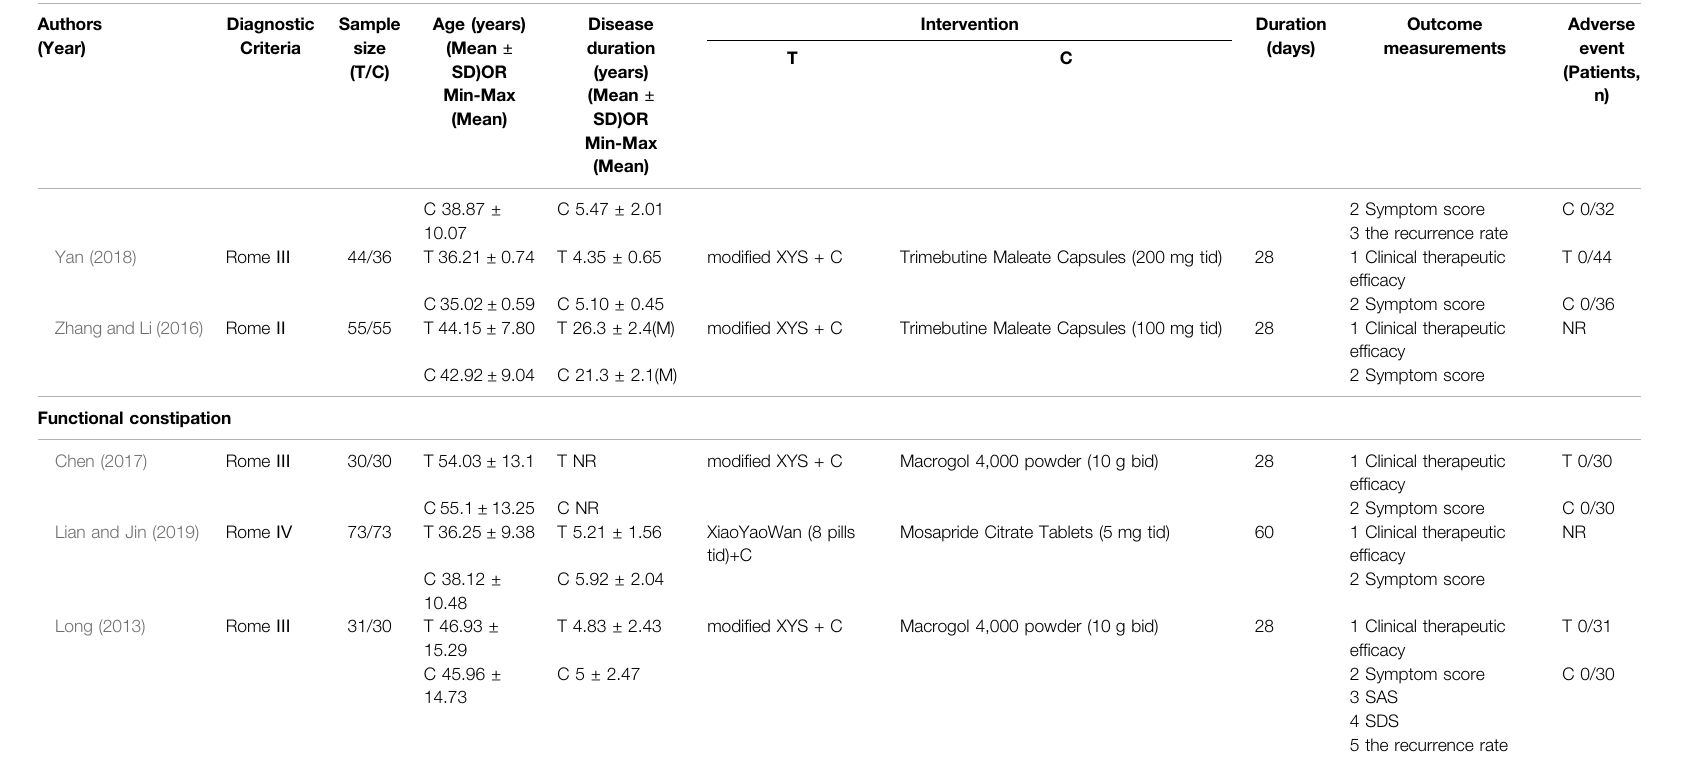
TABLE 1 | ( Continued ) Characteristics of the included